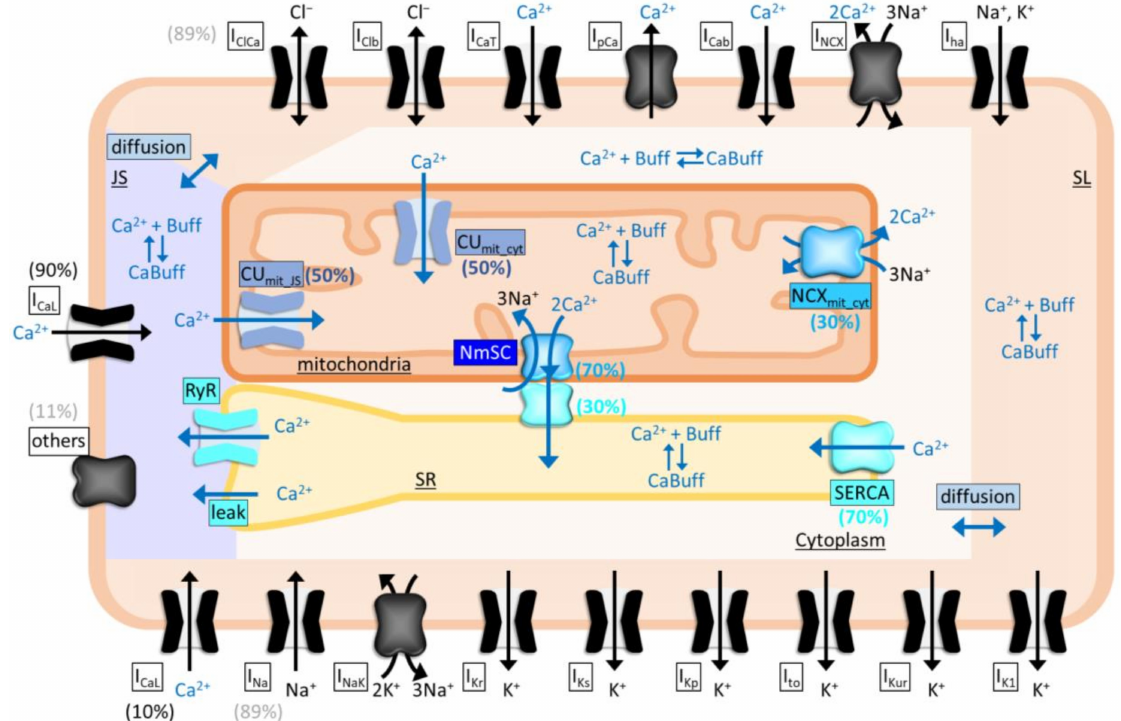
Figure 8. Schematic presentation of the mathematical model of HL-1 cardiomyocytes with mitochondria–SR interaction (MSI model). Distribution of L-type Ca 2+ channel (I CaL ) and other membrane channels/transporters (others) in junctional space (JS)/subsarcolemmal space (SL) are indicated in parenthesis with black and gray, respectively. Functional coupling of NCLX and SERCA is expressed by assuming that Ca 2+ , that is extruded through NCLX–SERCA complex (NmSC) from mitochondria, directly enters SR. Biased distributions of NmSC:NCX mit facing cytoplasm (NCX mit_cyt ) and NmSC:SERCA facing cytoplasm are set as 70%:30% and 30%:70%, according to the Manders’ coefficient of NCLX overlapping with SERCA2 and that of SERCA2 overlapping with NCLX as shown in Figure 6E, respectively. Distribution of CU mit facing junctional space (CU mit _ JS ):CU mit facing cytoplasm (CU mit _ cyt ) is set as 50%:50%, respectively, according to the super-resolution imaging of MCU by De La Fuente et al.